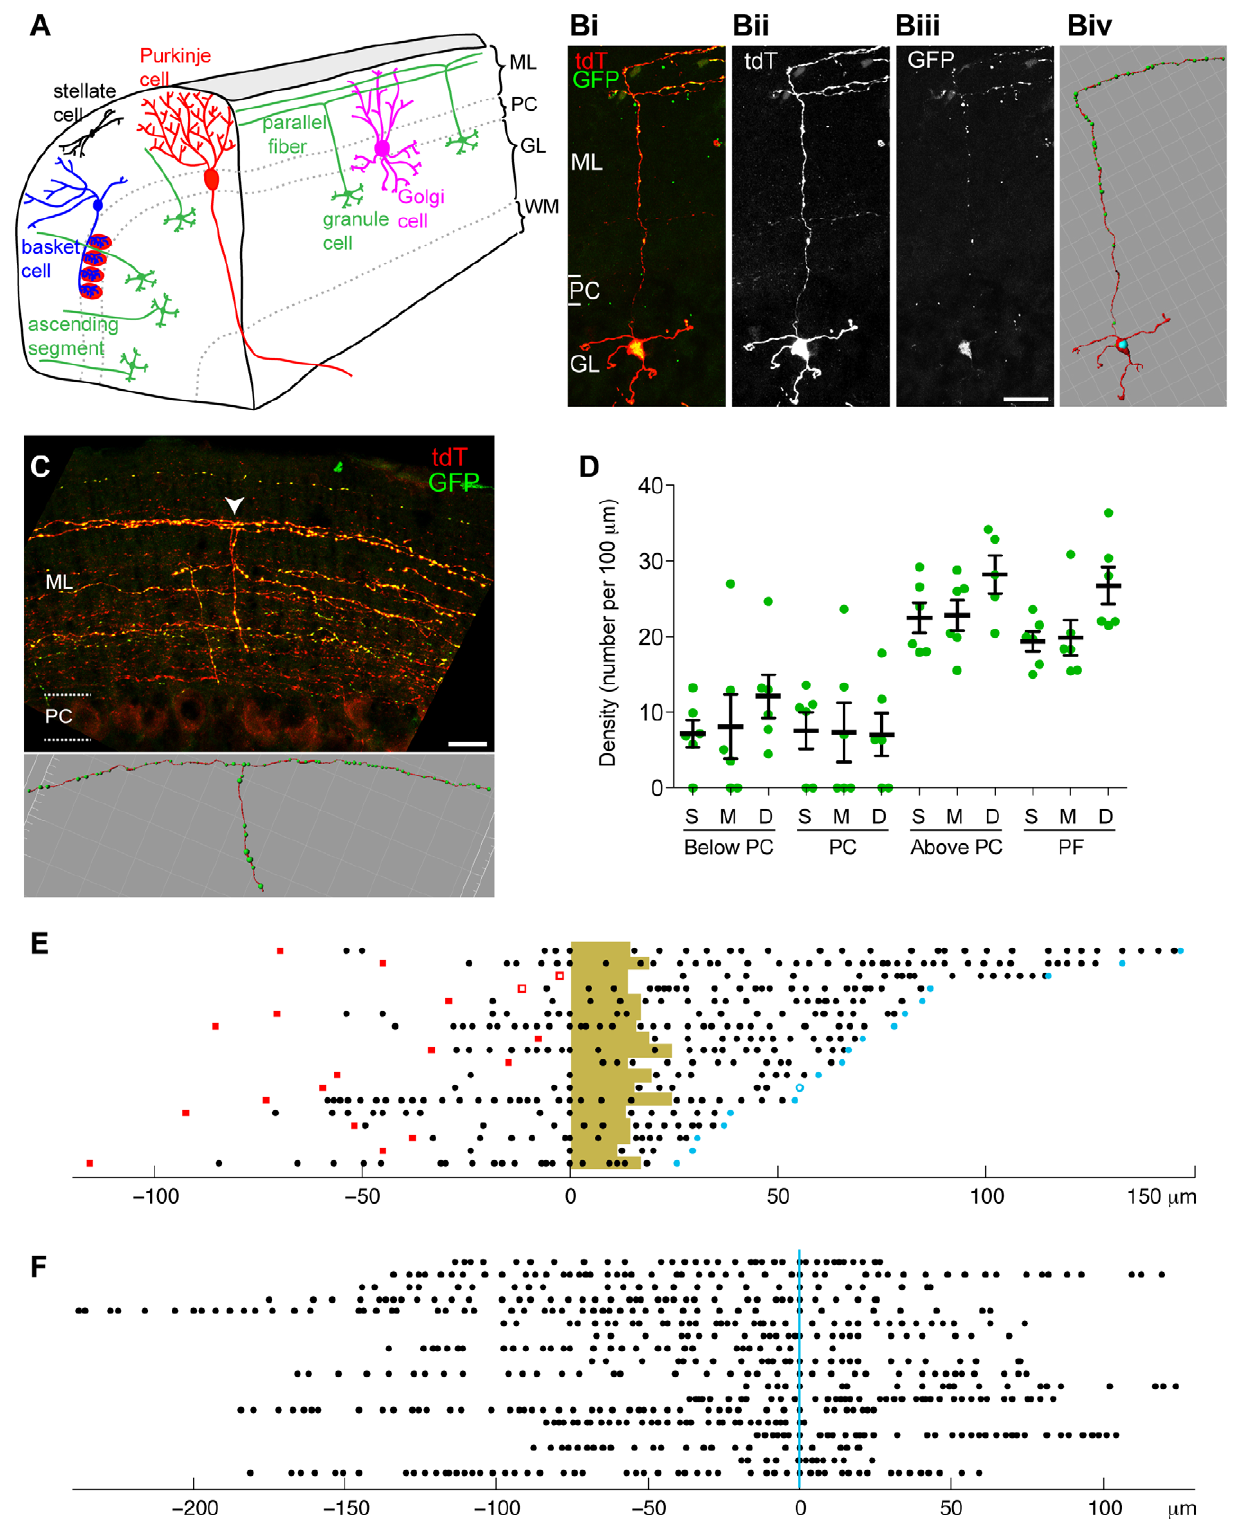
Figure 4. Quantitative analysis of Syp-GFP distribution in cerebellar granule cells. (A) Schematic illustration of the organization and major neuronal types of the cerebellar cortex. ML, molecular layer; PC, Purkinje cell body layer; GL, granular layer; WM, white matter. (B) Representative confocal image of a labeled mature cerebellar GC in a ZtTA/wt; TRE-Bi-SG-T/wt; b -actin-CreER/wt mouse with tamoxifen administered at P7 and dissected at P30, 7 days after Dox removal. The overlap between Syp-GFP puncta and tdT labeled GC processes is evident in the merged image, where Syp-GFP puncta appear yellow. Cerebellar layers (as illustrated in panel A) are marked with white lines. Scale bar=20 m m. The last panel shows a snapshot of the same cerebellar GC after filament and puncta tracing in Imaris. (C) Representative confocal image of labeled parallel fibers and a